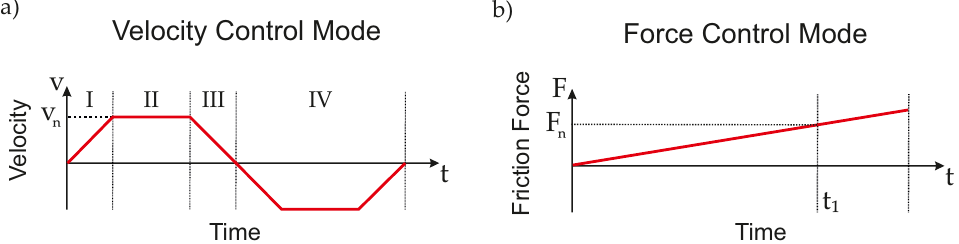
Figure 6. The velocity profile for the investigation of sliding friction force ( a ) and the force profile for the identification of breakaway force ( b